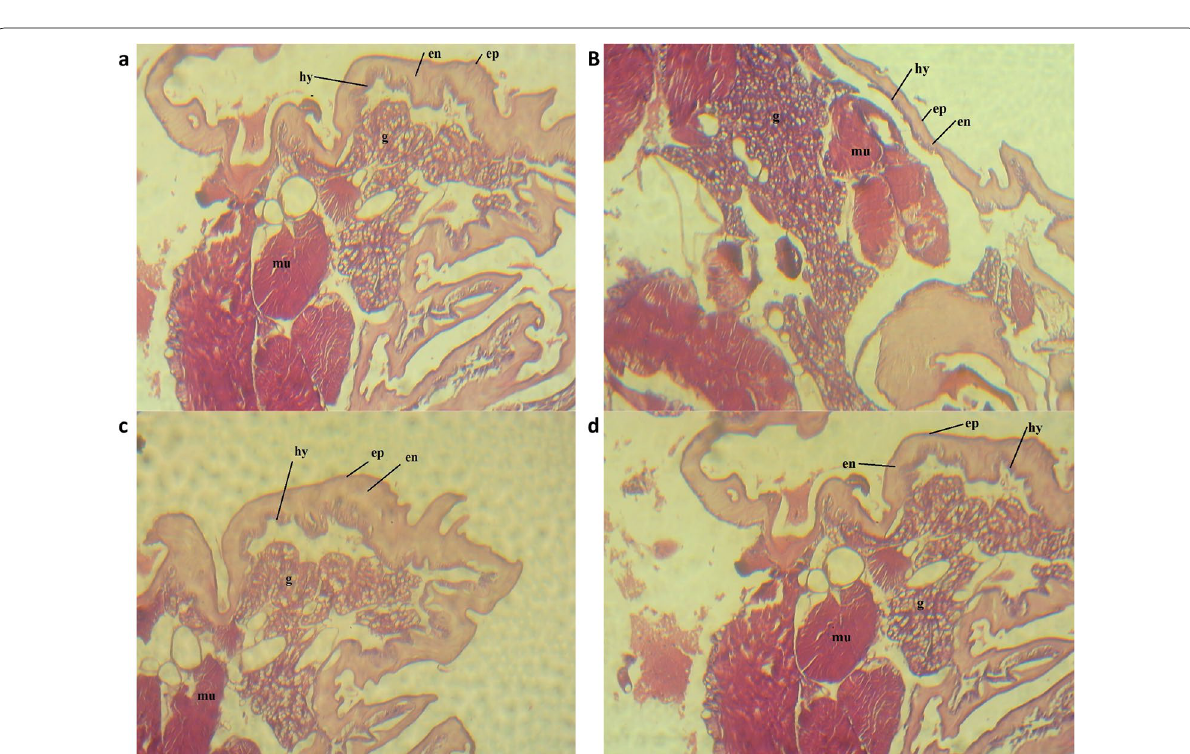
Means followed by the same letter in a column are not significantly different at the 5% level of probability (Duncan’s Multiple Range Test) [14]